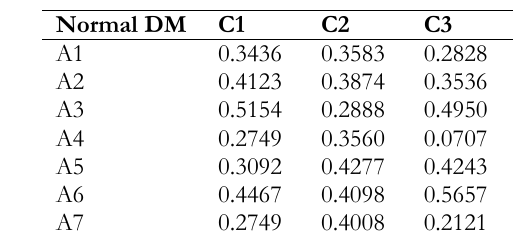
Table 23. Normal Decision-Making Matrix.